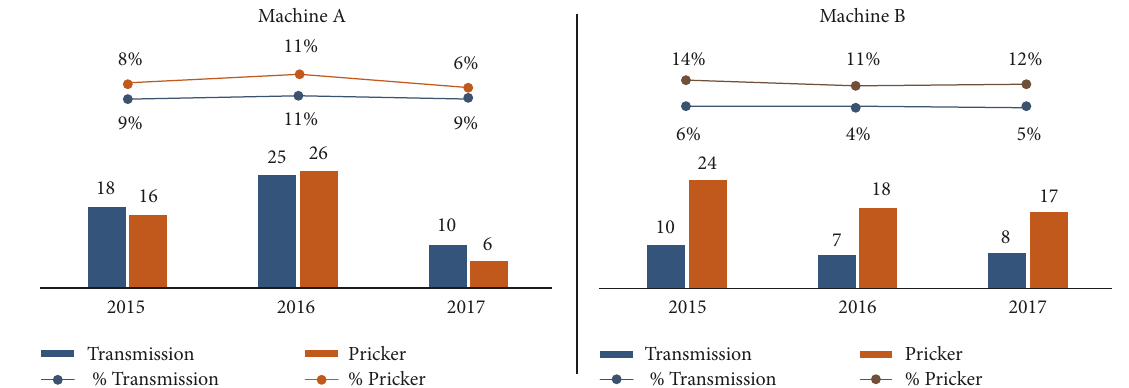
Figure 1: Maintenance distribution in each harvester.